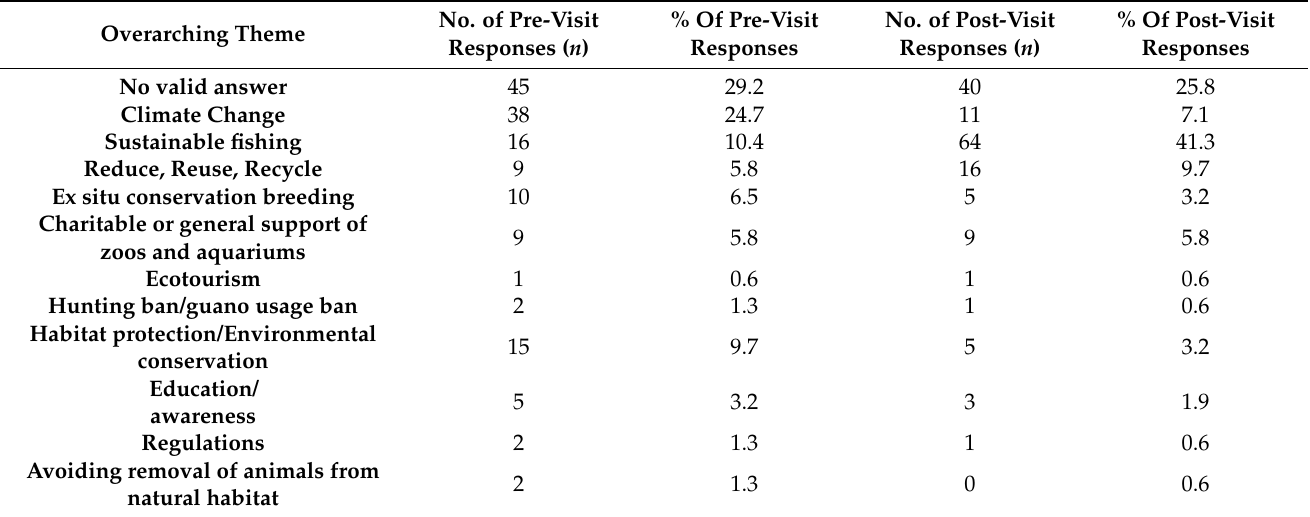
Table 3. Percentages of overarching themes that were identified, as coded by the authors, from responses provided to the open-ended question ‘Can you list any specific conservation actions you can take for the Humboldt Penguin’ asked of participants visiting a zoo in a pre- ( n = 154) and post-visit ( n = 155)